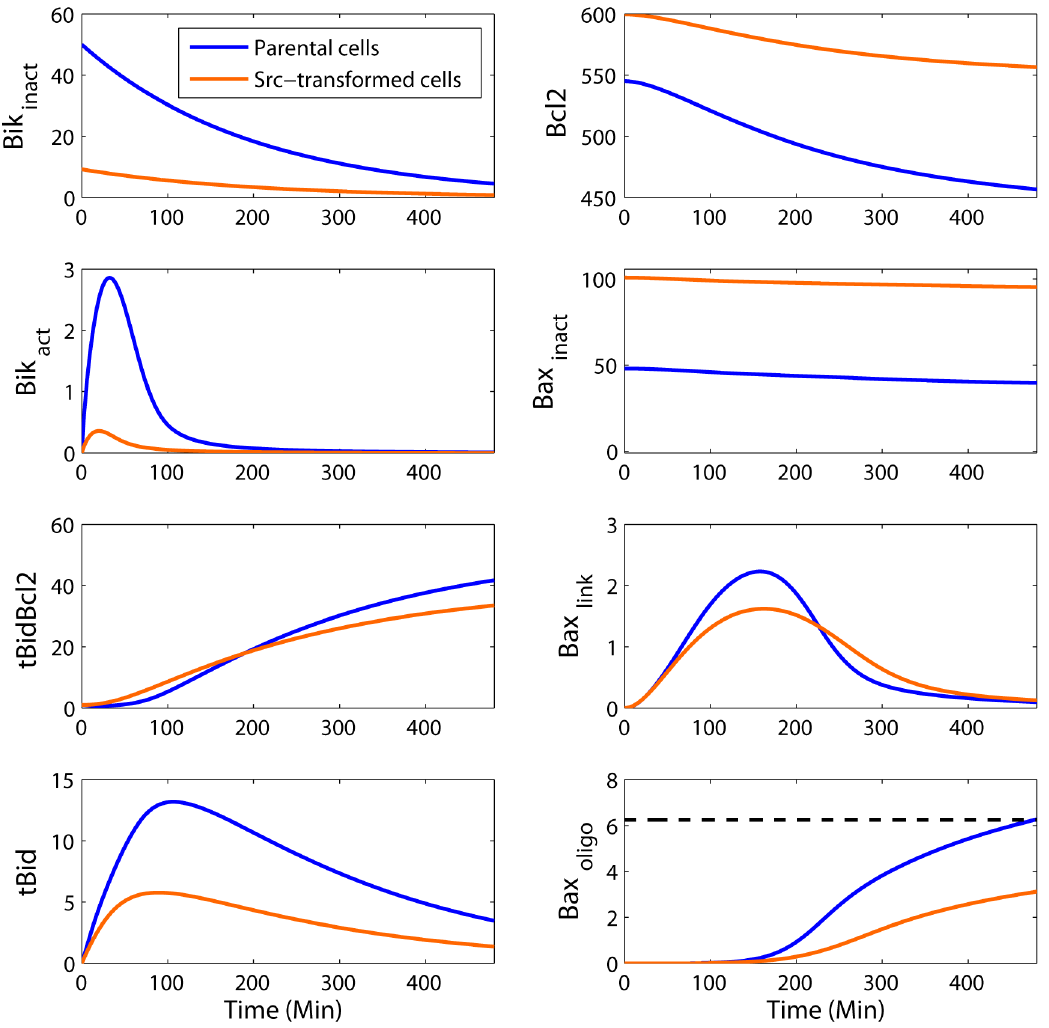
Figure 7. Simulated molecular response to staurosporine exposure of parental (blue) and Src-transformed (orange) NIH-3T3 cells. Higher Bik concentration in normal fibroblasts led to a higher concentration of Bik act and of free tBid . tBid molecules then activated Bax inact into Bax link which oligomerized until reaching the apoptotic threshold in control cells but not in Src-transformed cells. Time is expressed in min and concentrations in nM.